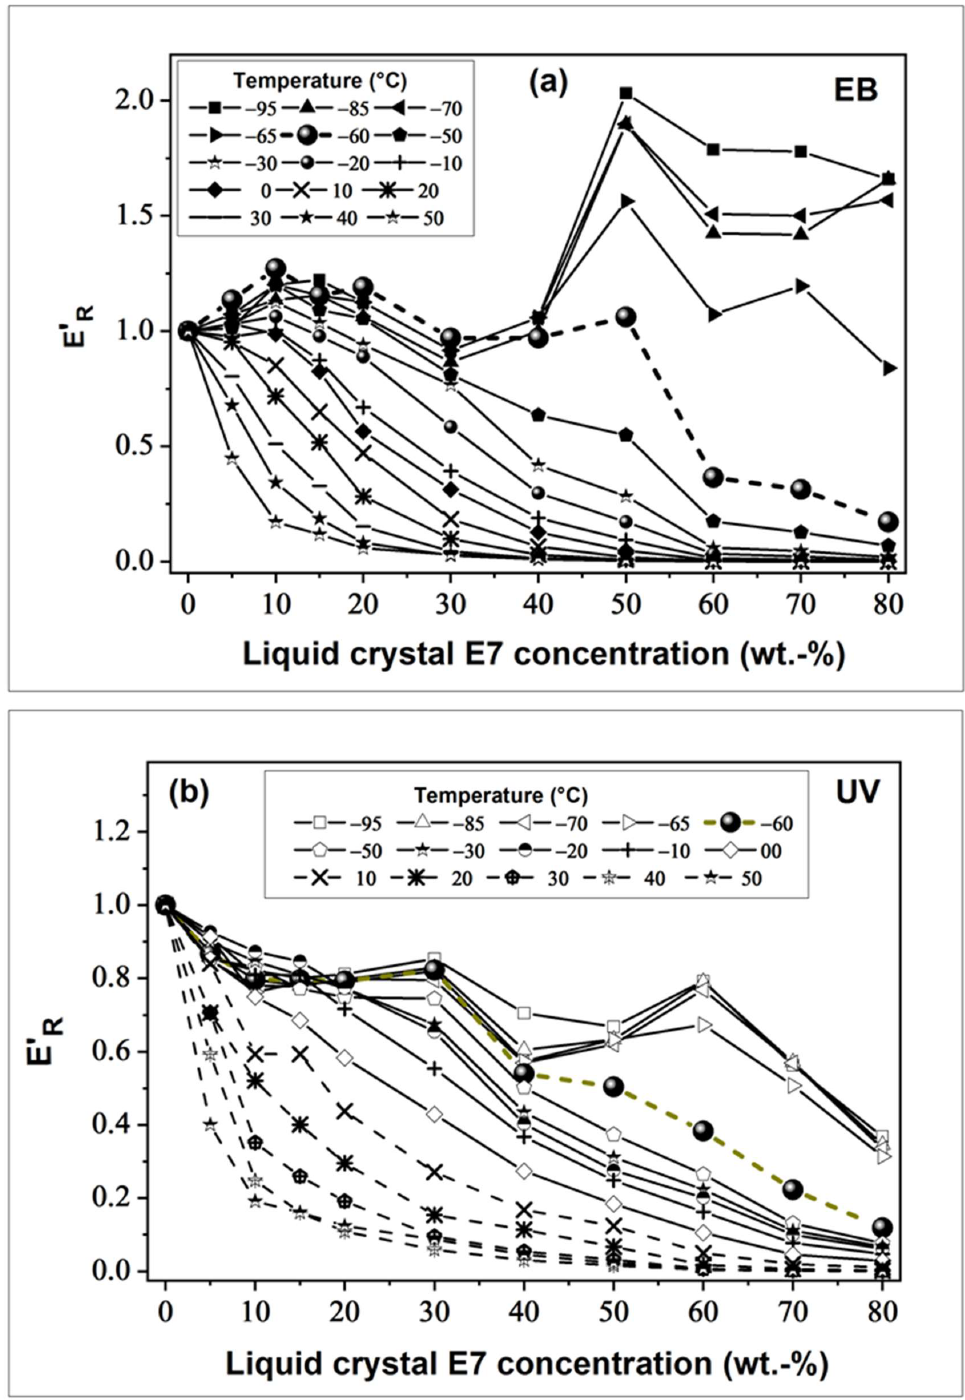
Figure 6. Reduced storage tensile moduli E’ R as function of LC concentration determined at different temperatures for ( a ) EB- and ( b ) UV- cured TPGDA/E7